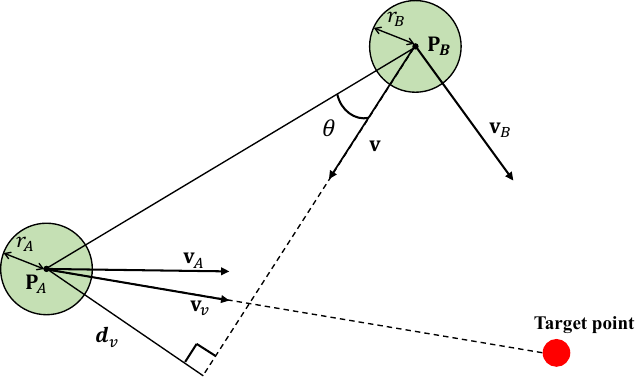
Figure 6. Schematic diagram of the expected velocity and the relative vertical distance. The green disks represent the agent and the obstacle, respectively, and the red point represents the target point. The relative vertical distance ( d v ) is defined as Equation